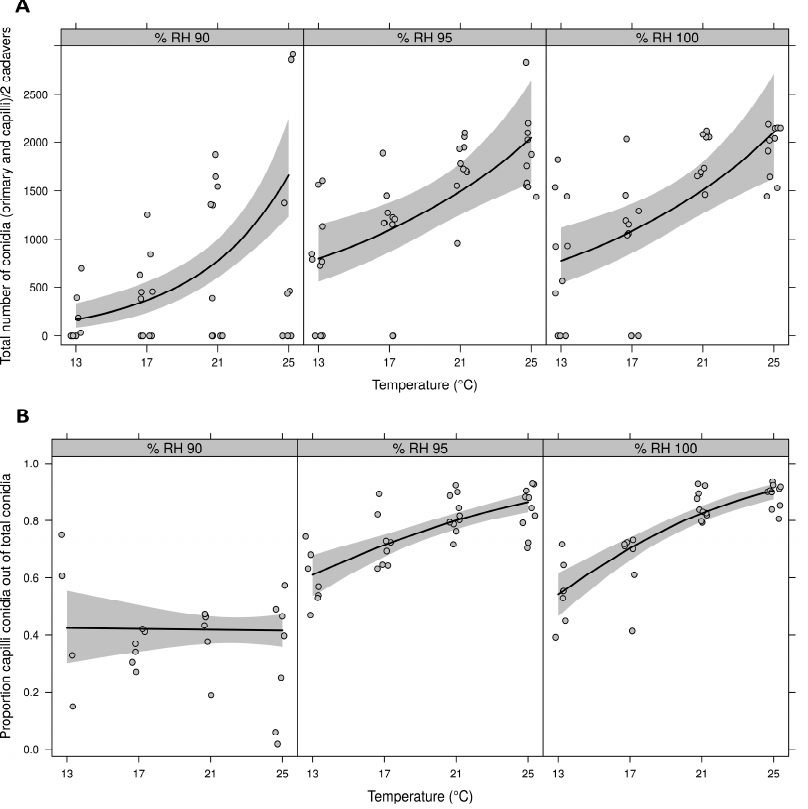
Figure 2. Effect of relative humidity (RH) (80, 85, 90, 95, 100%) and temperature (13, 17, 21, and 25 °C) on ( A ) Mean total number of conidia (primary conidia and capilliconidia)/cadaver for a Brazilian Neozygites floridana isolate (ESALQ 1420) ( B ) Proportion of Neozygites floridana capilliconidia out of the total number of conidia. RH 80% and 85% not shown, as no sporulation was detected.